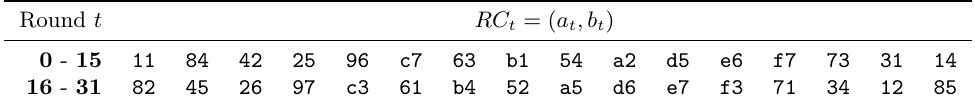
Table 2: The round constants of